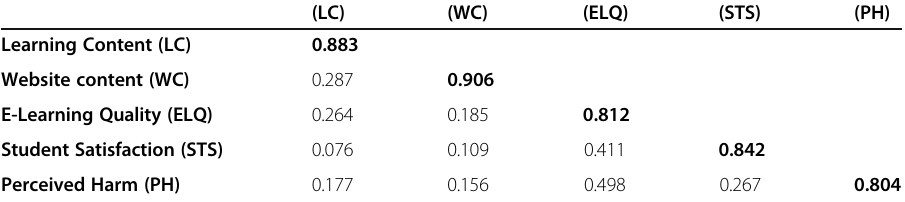
Table 3 Fornell-Larcker criteria for divergent